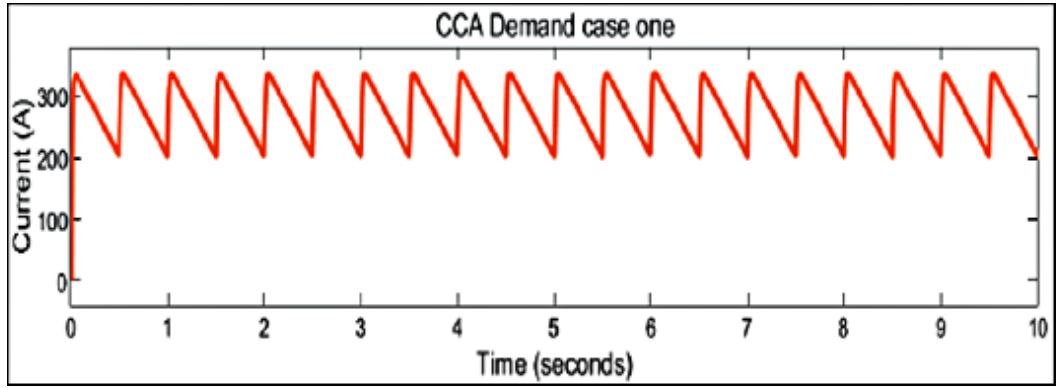
Figure 12. CCC demand for the two cases.